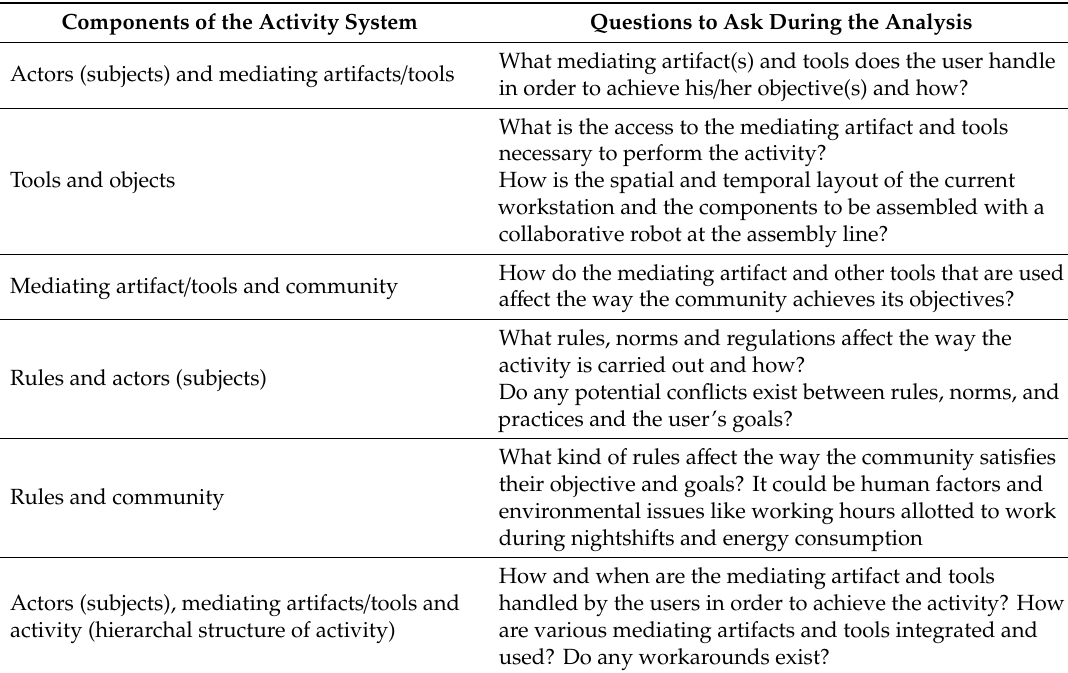
Table 3. Guiding questions to raise during the analysis based on the interrelations within the activity system during the analysis (adapted from